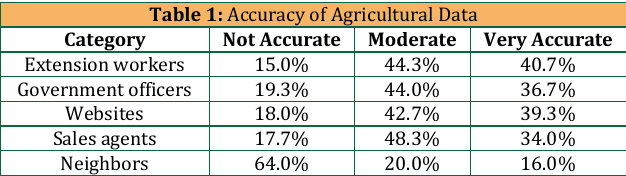
Table 1: Accuracy of Agricultural Data Category